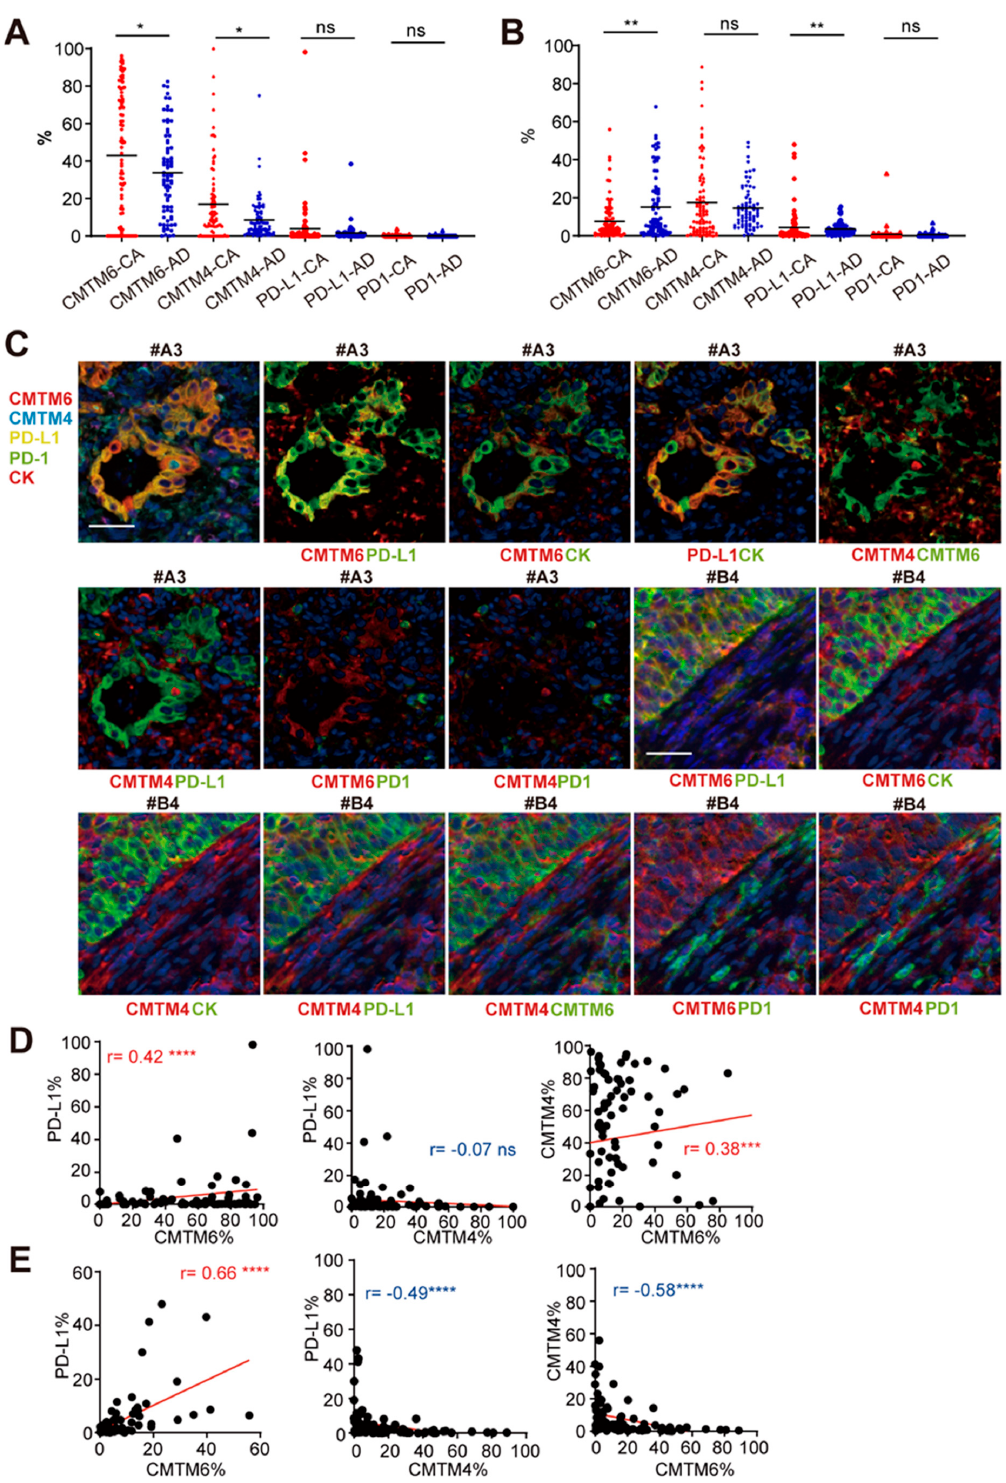
Figure 2. CMTM6 is elevated in tumor epithelial cells in gastric cancer tissues. ( A , B ) Expression of CMTM6, CMTM4, PD-L1, and PD-1 in the epithelial ( A ) and mesenchymal ( B ) region of 180-dot commercial gastric adenocarcinoma tissue microarray. CA: cancer, AD: Adjacent. ( C ) Representative images of co-localization pattern of indicated molecules in GC tissue microarray using multiplexed immunofluorescence staining (MIS), scale bar: 39 µ m. ( D , E ) Correlation analysis of CMTM6, PD-L1, and CMTM4 quantified by MIS in epithelial ( D ) and mesenchymal ( E ) region in the tissue microarray. * p < 0.05, ** p < 0.01, *** p < 0.001, **** p < 0.0001, “ns”, no significance, all by the Spearman